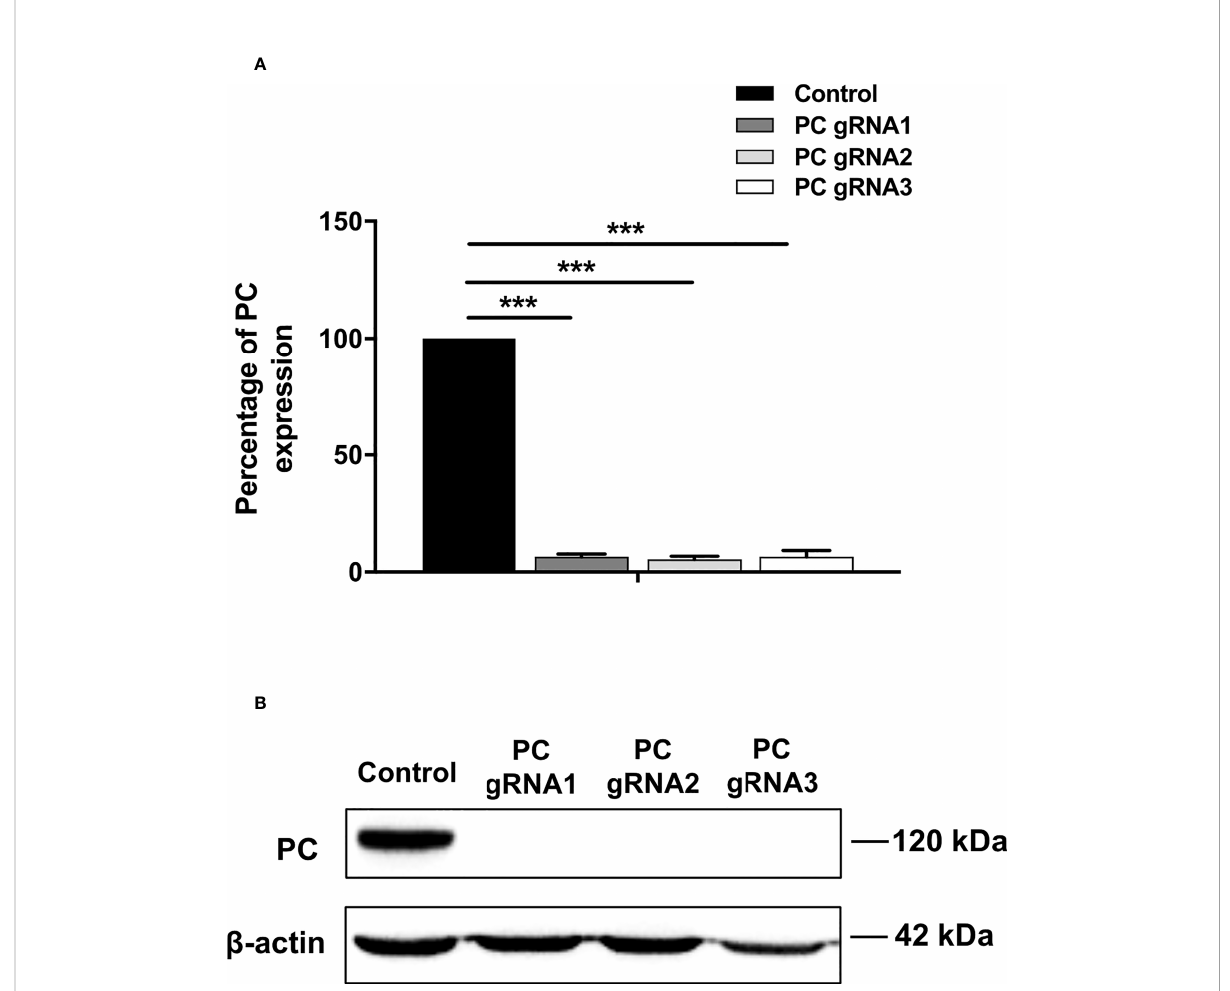
FIGURE 1 Expression of PC mRNA and protein in PC KO cell lines. (A) Q-PCR analysis of PC mRNA. The PC/18s rRNA expression of PC KO cells was relative to that of HT-29-transfected with empty vector (control), which was arbitrarily set to 100%. The results were obtained from three independent experiments, and the statistical analysis was conducted using ANOVA where ***p < 0.001. (B) Representative Western blot analysis of PC expression in three PC KO HT-29 clones (PC-gRNA1, PC-gRNA2, and PC-gRNA3), compared to HT-29 cells transfected with empty vector (control). Western blot was performed from three independent